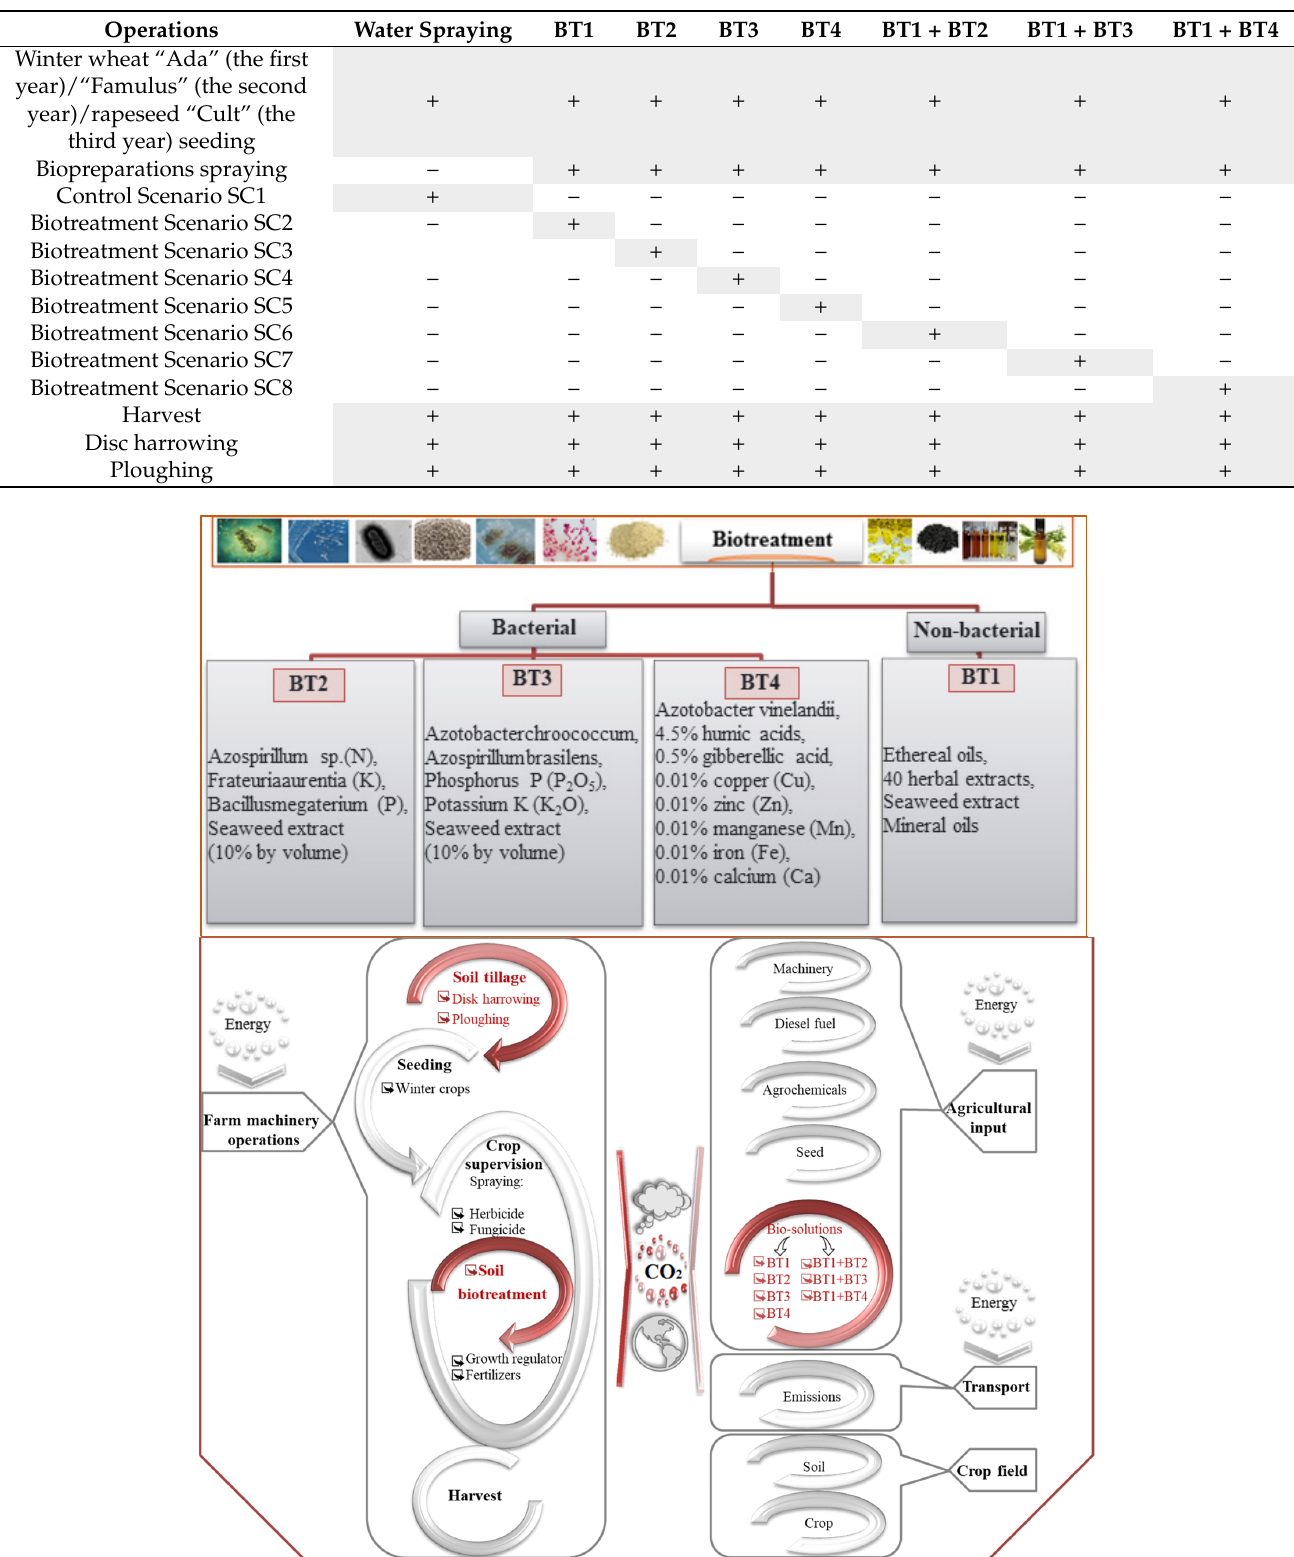
Table 1. Different scenarios of soil bio-impact.